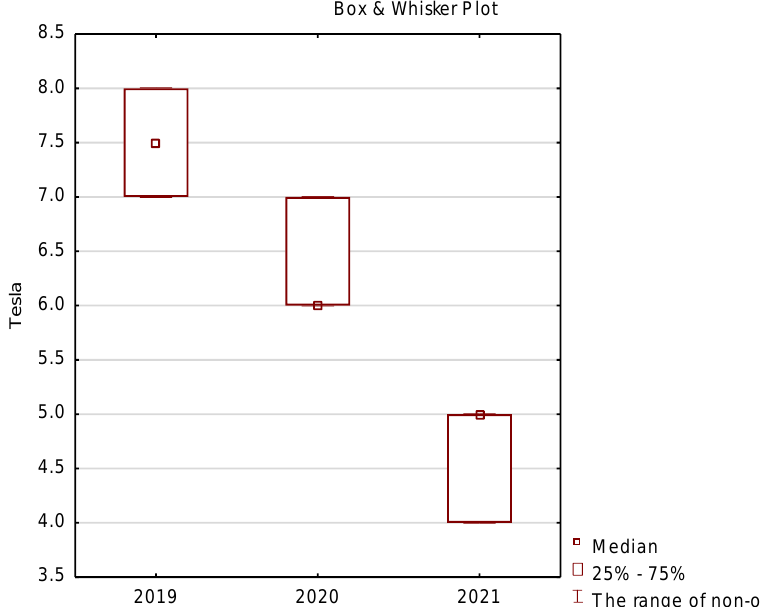
Figure 15. Box plots for the analysis of vehicle charging method — Tesla.